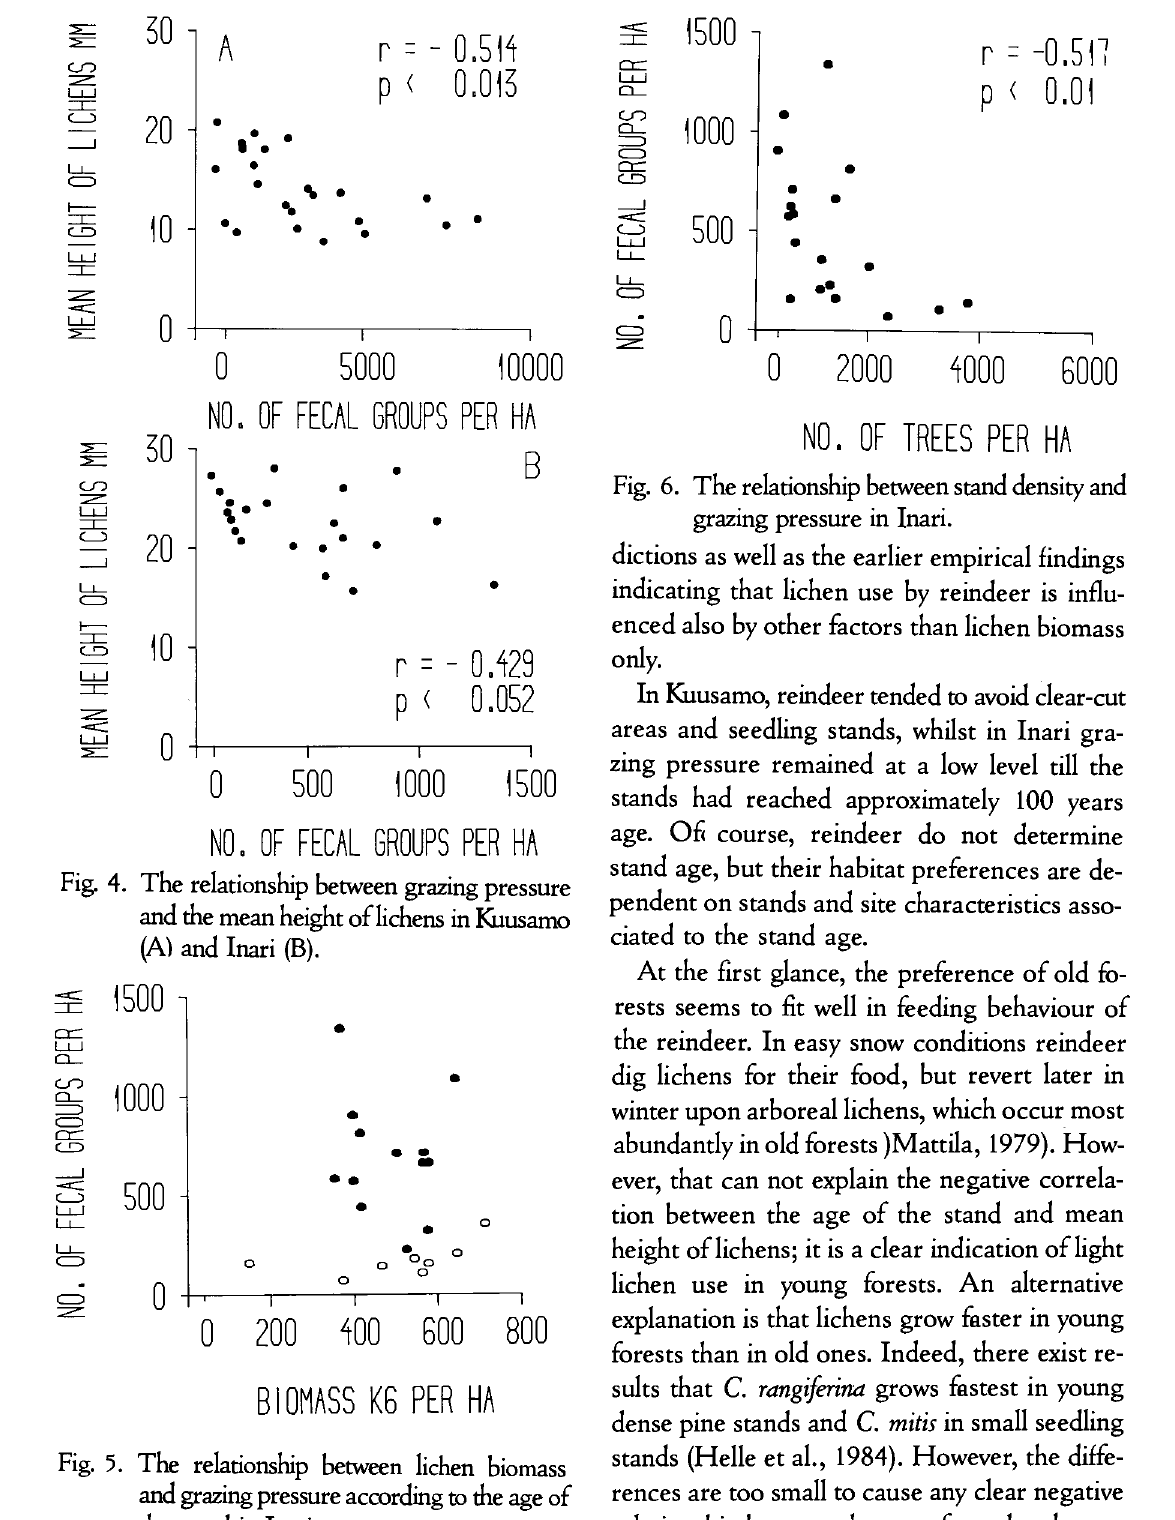
Fig. 5. The relationship between lichen biomass and grazing pressure according to the age of the stand in Inari.